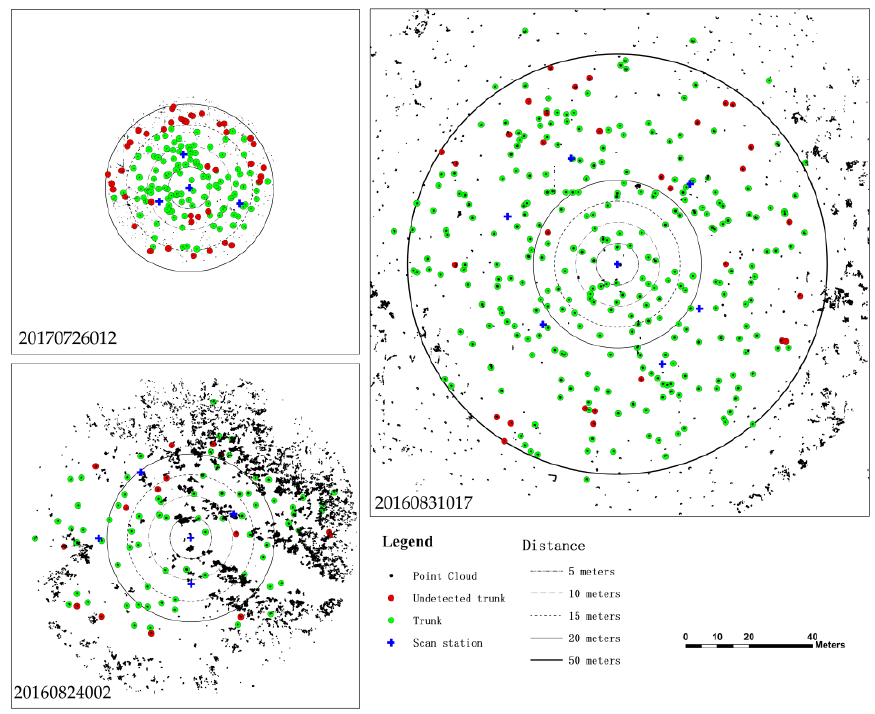
Figure 8. Results of trunk extraction in different density plots of Pinus yunnanensis . Table 4. Effects of Forest Density and Distance on Scanning Range and Accuracy.